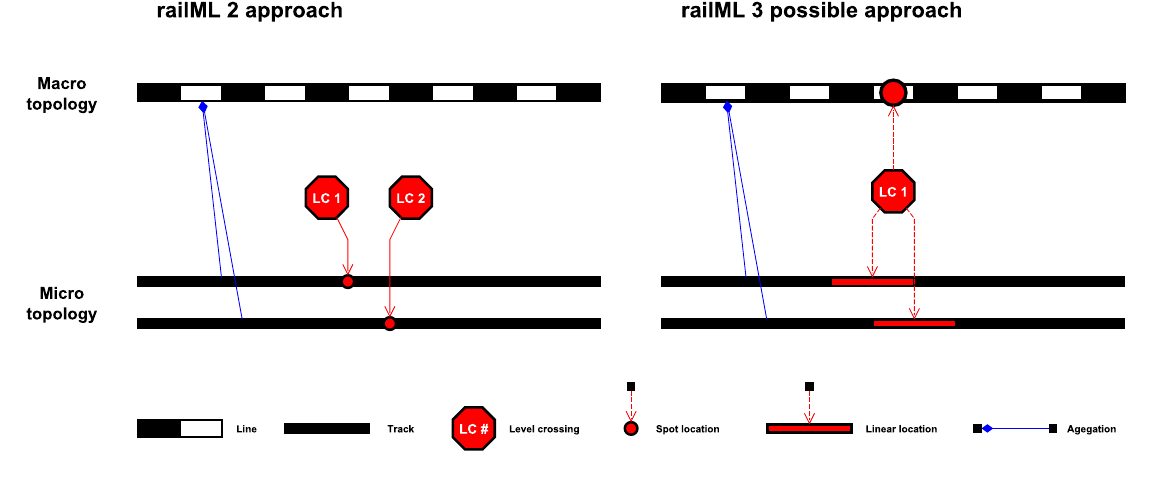
Figure 2. Illustration of different approaches in locating of entities in the scope of railML 2 and railML